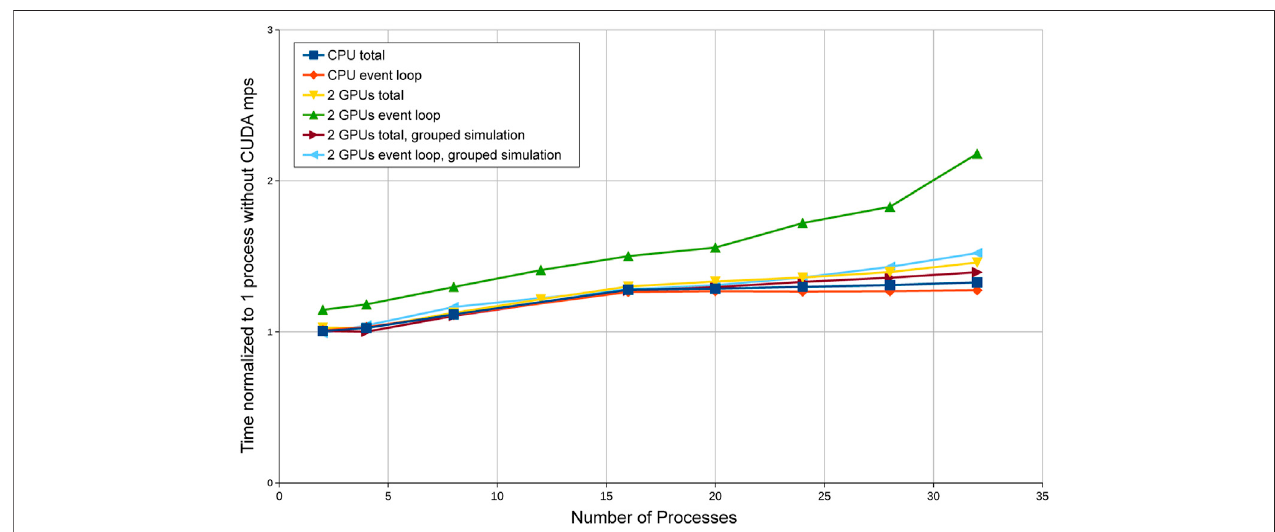
FIGURE 1 | Normalized timing of multiple concurrent jobs running on the same node sharing GPUs with nvidia-cuda-mps-server.